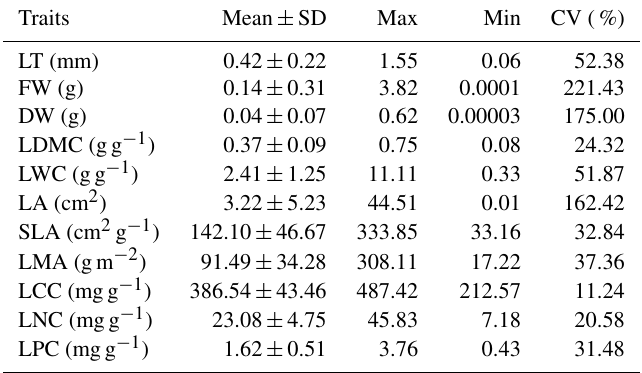
Table 1. Summary of leaf functional traits in the TiP-Leaf dataset.